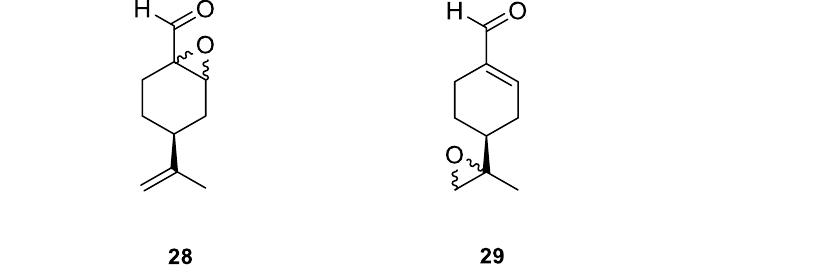
Figure 15. Selected PAH epoxide derivatives.